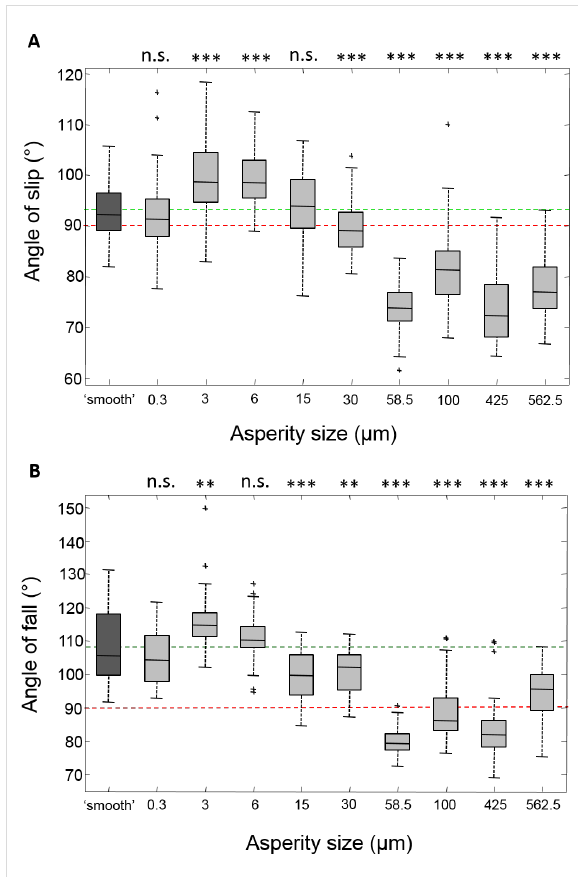
Figure 1: Box plots of slip (A) and fall (B) angles of free climbing tree frogs on different rough surfaces. Smooth glass is on the left, with in- creasing roughness (larger asperities) moving right across the x -axis. The red dashed line through 90° on the plot shows where friction forces are at a maximum, and where adhesive forces begin to play a role. The green dashed lines show mean values on the smooth sur- face to aid comparisons. Statistical tests which compare each surface with the smooth surface performance are shown above each box (due to the Bonferroni correction: 95% confidence interval p = 0.0055 (*), 99% p = 0.0011 (**), 99.9% p = 0.00011 (***), n.s. = not